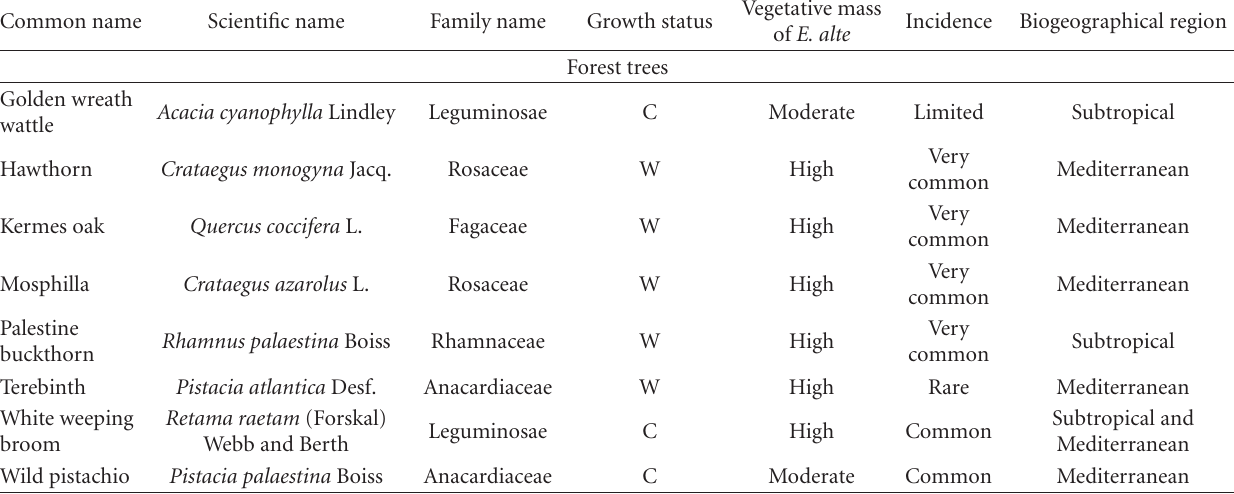
a character shared with many noxious weed species. E. alte, however, is considered as a weed in Egypt